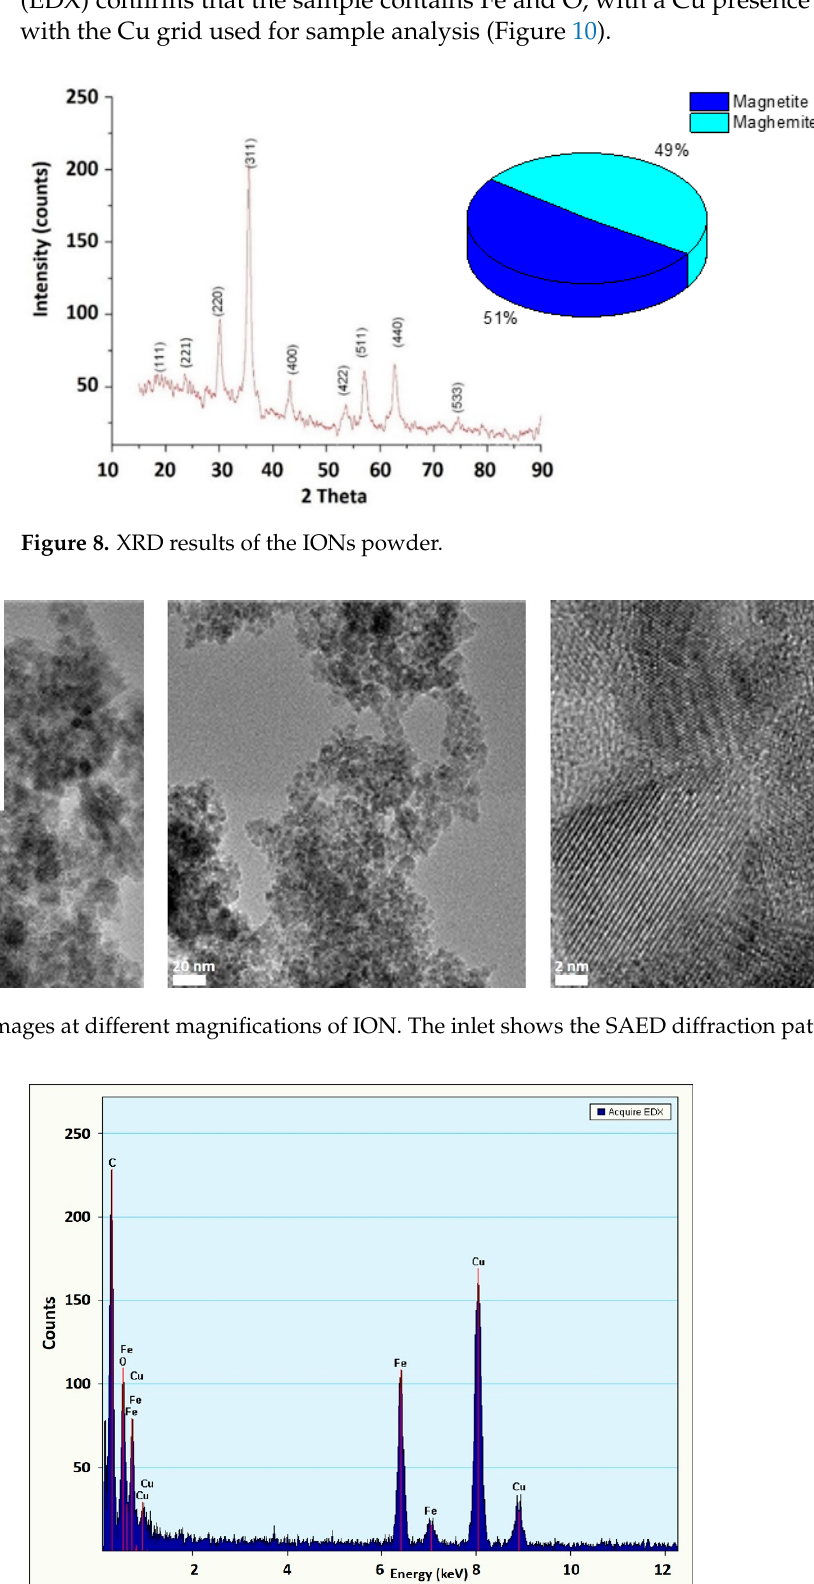
Figure 9. TEM images at different magnifications of ION. The inlet shows the SAED diffraction pattern. Figure 10. EDX image of the ION sample corresponding to the TEM image presented in Figure 9.